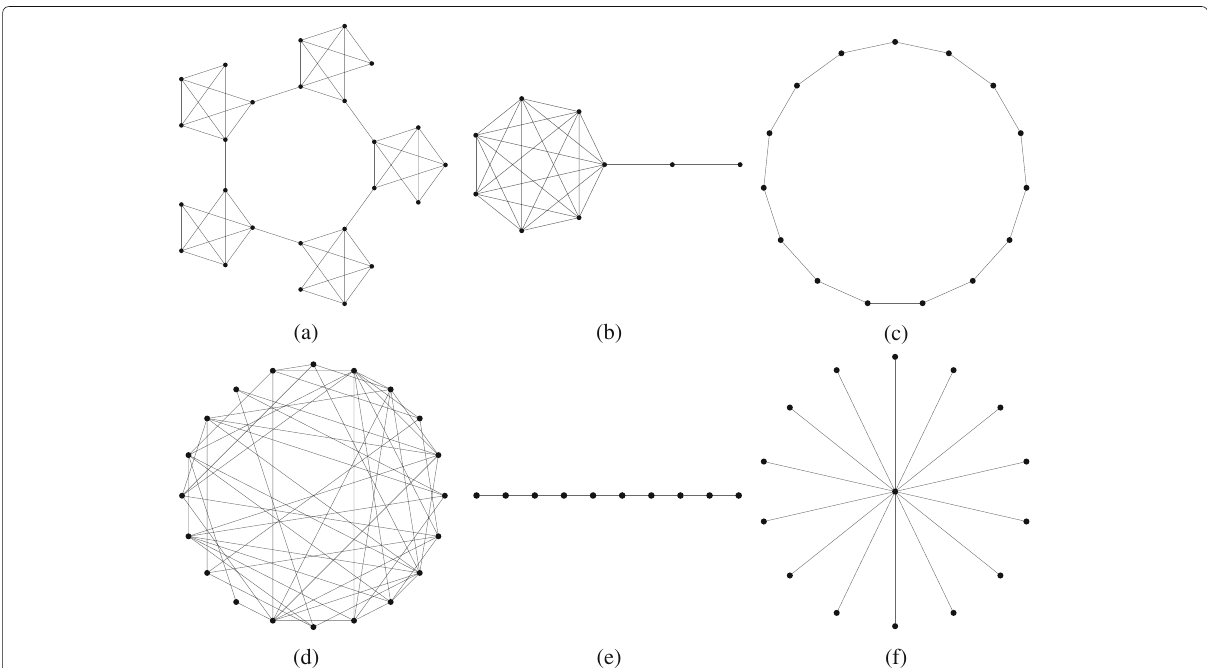
Fig. 4 Plots of graphs used in numerical tests. For clarity, we keep the number of nodes limited, and in case of random graphs, we show typical realizations. ( a ) Caveman graph. ( b ) Lollipop graph. ( c ) Cycle graph. d ) Erd˝os Rényi graph. ( e ) Line graph. ( f ) Star graph